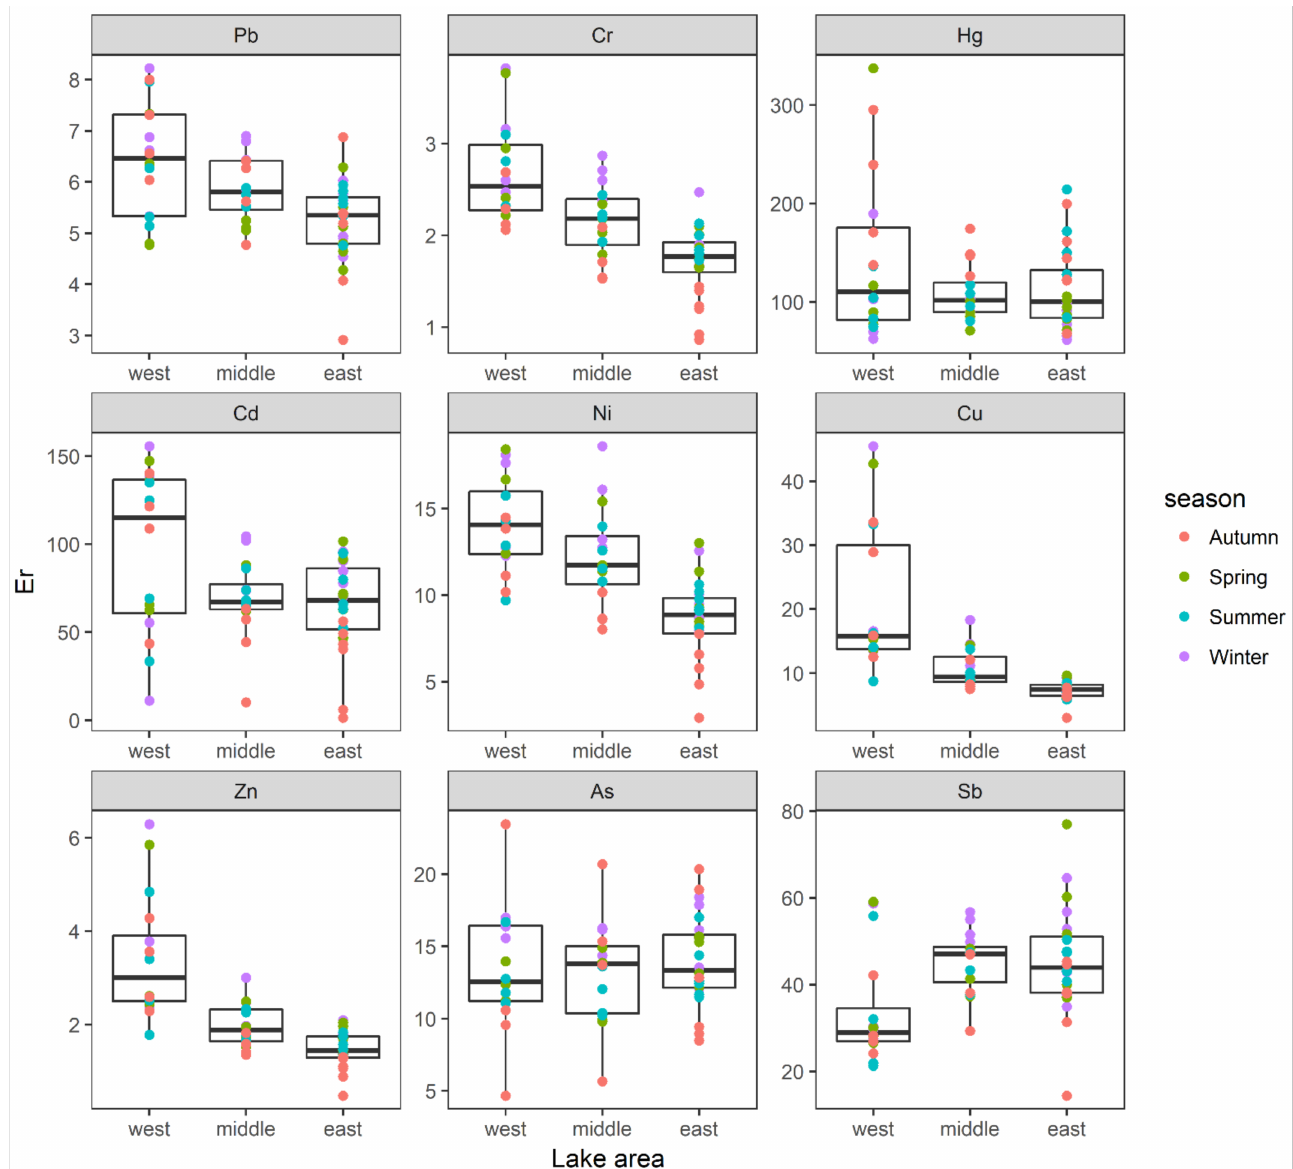
Figure 6. The spatial distributions of Er of each heavy metal were displayed in three lake areas. Boxes represent the 25th to 75th percentiles; straight lines within the boxes mark the median; and the small dots indicate the average values of four